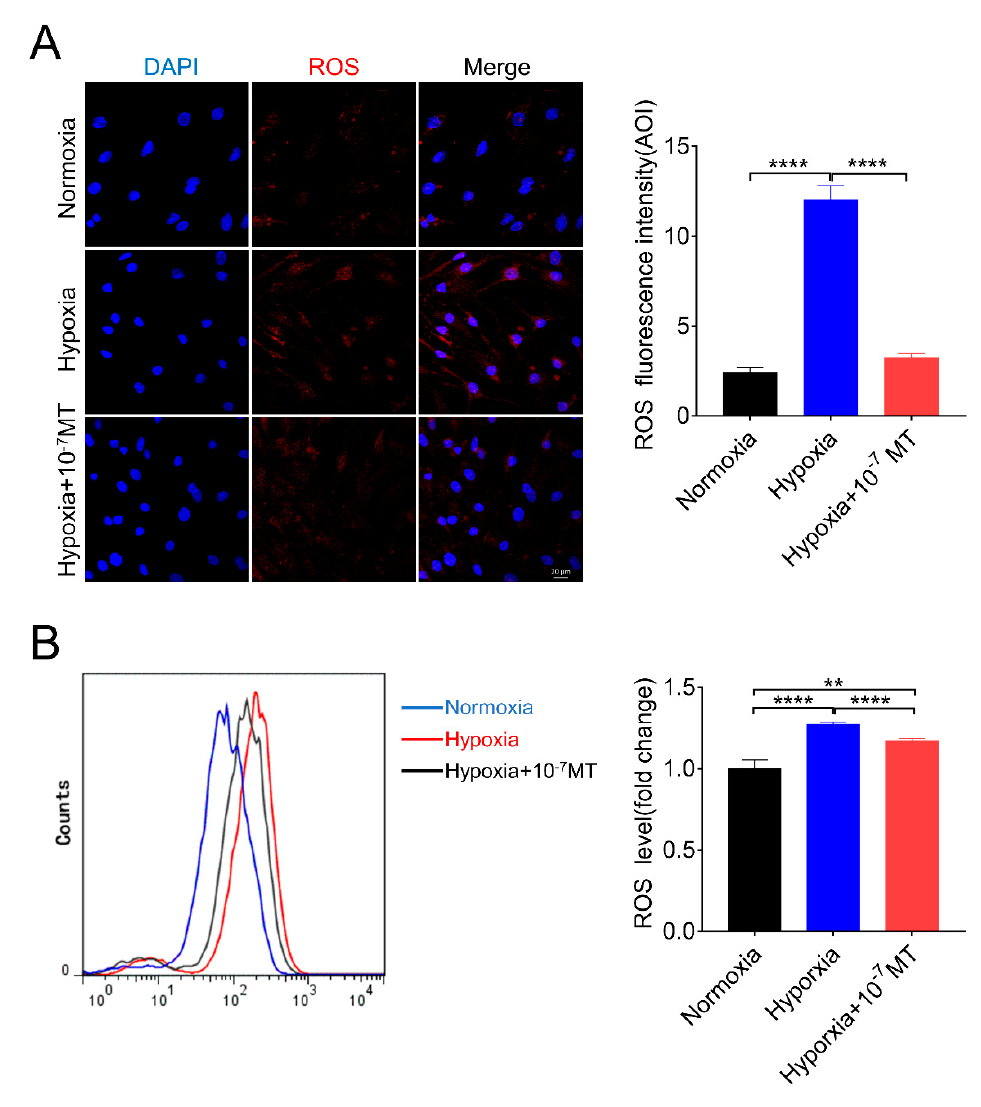
Figure 2. Effect of MT on reactive oxygen species (ROS) levels of porcine GCs in normoxia and hypoxia environment. ( A ) The immunofluorescence analysis of ROS levels in porcine GCs cultured in normoxia, hypoxia, and hypoxia plus 10 − 7 M MT. ( B ) The flow cytometry analysis of ROS levels of porcine GCs treated in normoxia, hypoxia, and hypoxia plus 10 − 7 M MT. ** p < 0.01 was considered highly significant; **** p < 0.0001 was considered extremely significant.